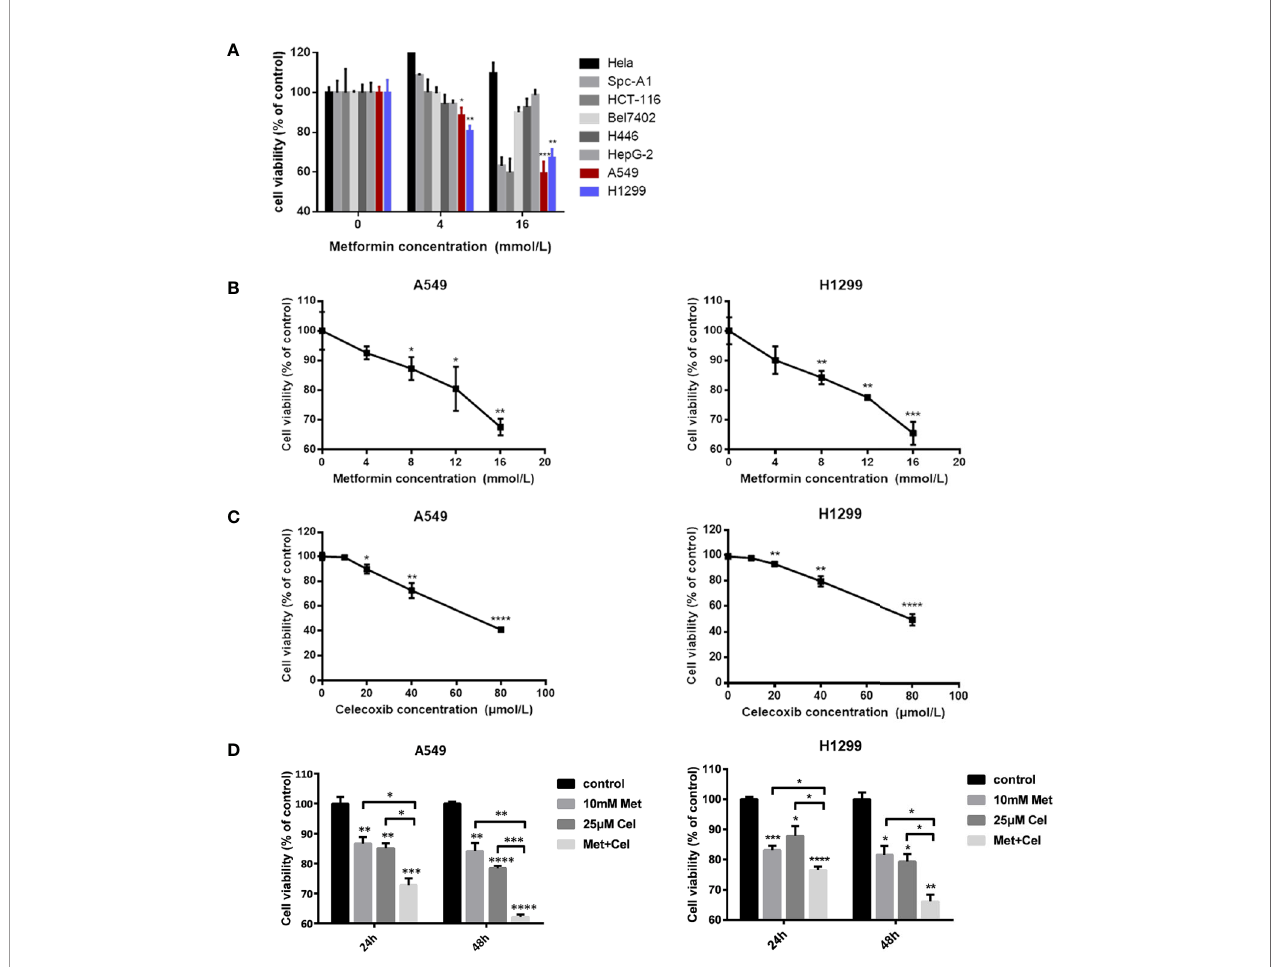
FIGURE 1 | Screening of cell lines and combination conditions. (A) Effects of metformin on cell vitality of different cancer cell lines. (B) A549 cells and H1299 cells were treated with metformin at different concentrations (0, 4, 8, 12, 16 mM) for 24 h, and the cell viability was assessed by CCK8 assay. (C) A549 cells and H1299 cells were treated with celecoxib at different concentrations (0, 10, 20, 40, 80 m M) for 24 h and the cell viability was assessed by CCK8 assay. (D) A549 cells and H1299 cells were treated with 10 mM metformin and/or 25 m M celecoxib under different time (24 h or 48 h), and the cell viability was assessed by CCK8 assay. Data are represented as mean ± SD. * p < 0.05, ** p < 0.01, *** p < 0.001, **** p <